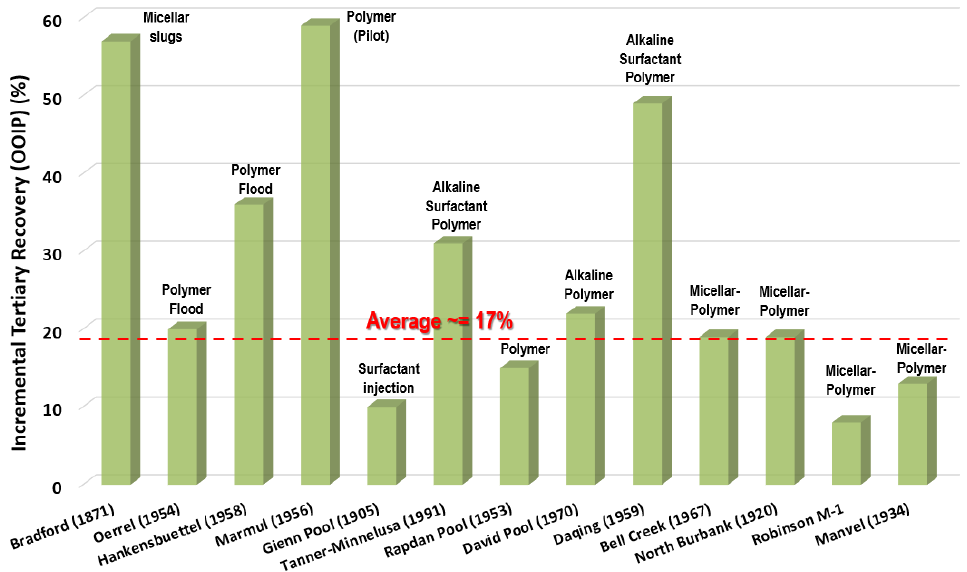
Figure 3. Incremental tertiary recoveries by chemical injection in selection of successful EOR projects; the dates in the x-axis indicate the discovery years of the